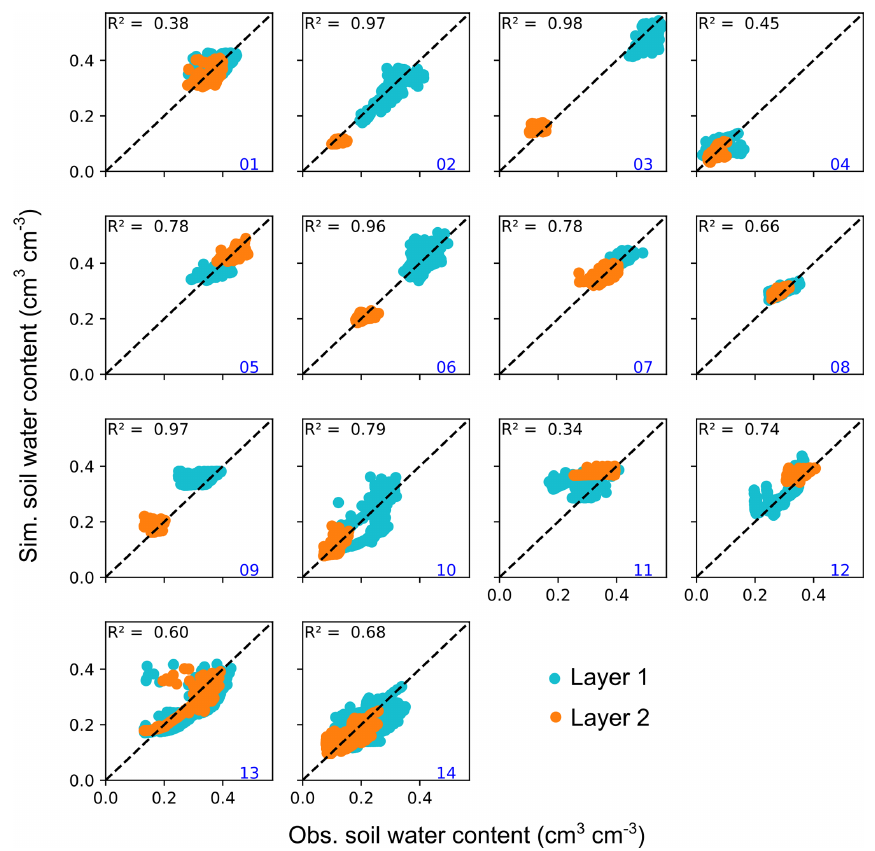
Figure A4. Model validation showing the coefficient of determination ( R 2 ) and scatterplots of the simulated and observed soil water content from the upper (layer 1) and lower (layer 2) soil layers for the 14 sites: (01) Lauterach, (02) Leutasch, (03) Achenkirch, (04) Gschlössbo- den, (05) Sillianberger Alm, (06) Zettersfeld, (07) Elsbethen, (08) Gumpenstein, (09) Aichfeld-Murboden, (10) Kalsdorf, (11) Pettenbach, (12) Schalladorf, (13) Lobau, and (14) Frauenkirchen. The dashed diagonal black line is the 1 : 1 line. Validation periods are given in Ta- ble A2.